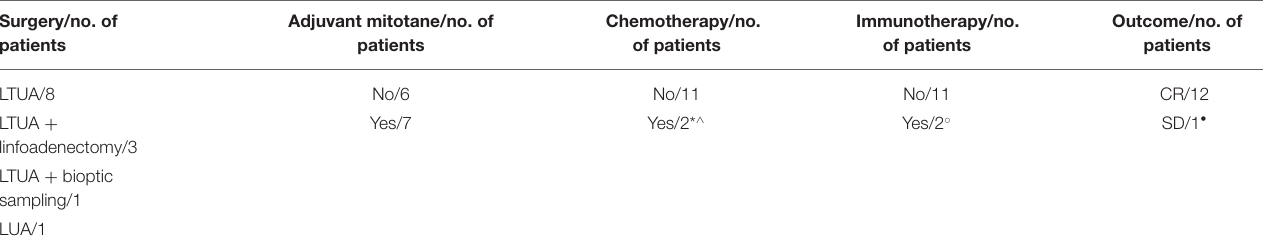
TABLE 2 | Therapeutic approach. Surgery/no. of patients